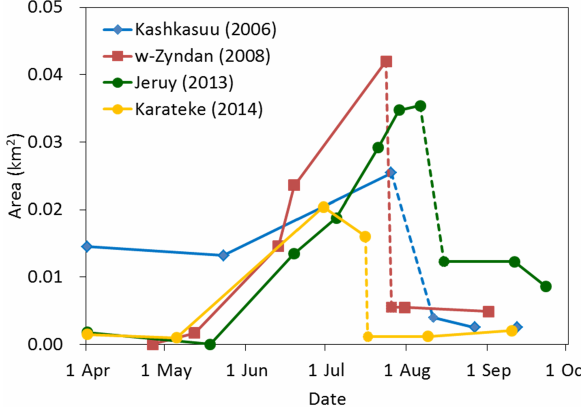
Figure 4. Seasonal area changes of four short-lived glacial lakes. Dashed line segments indicate